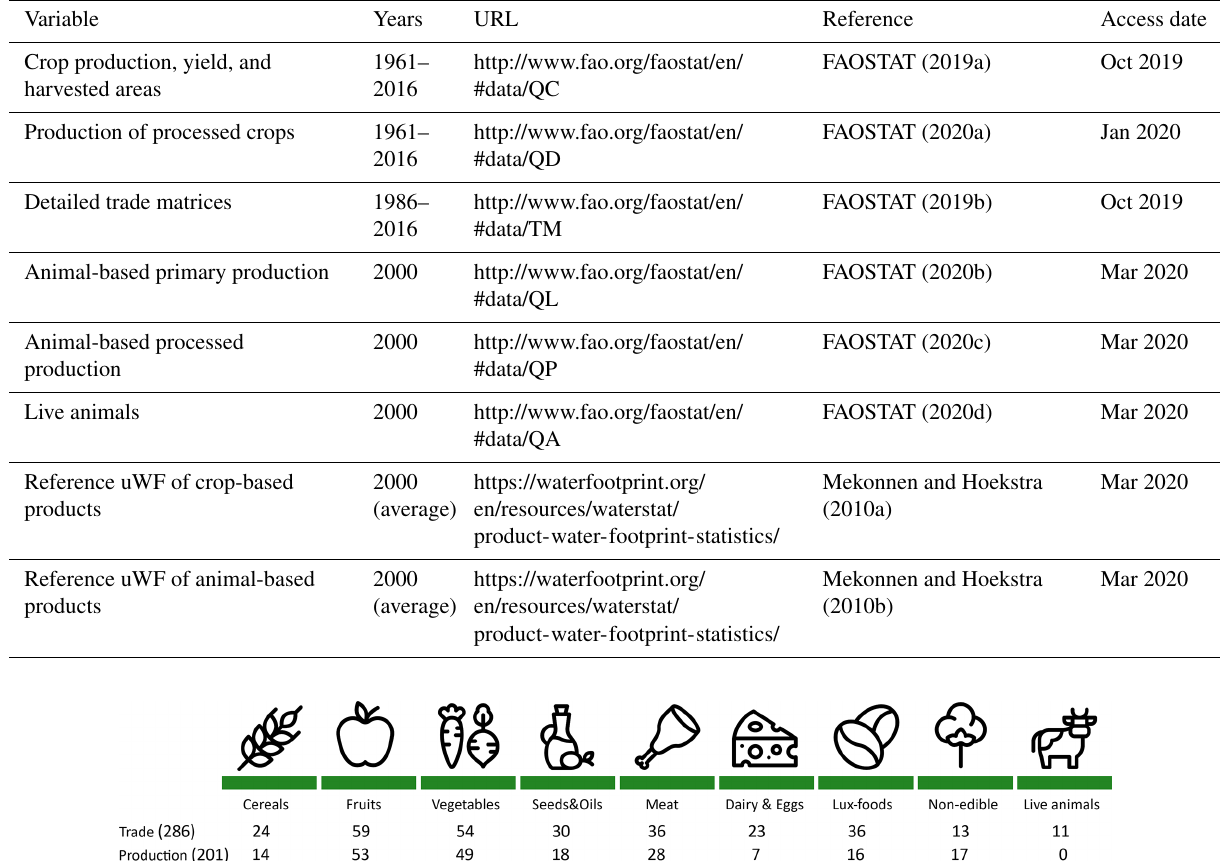
Figure 1. Commodities considered in the analysis, split into nine categories: number of commodities in the trade and production dataset. Icons designed by Freepik from Flaticon (https://www.flaticon.com/, last access: 5 May